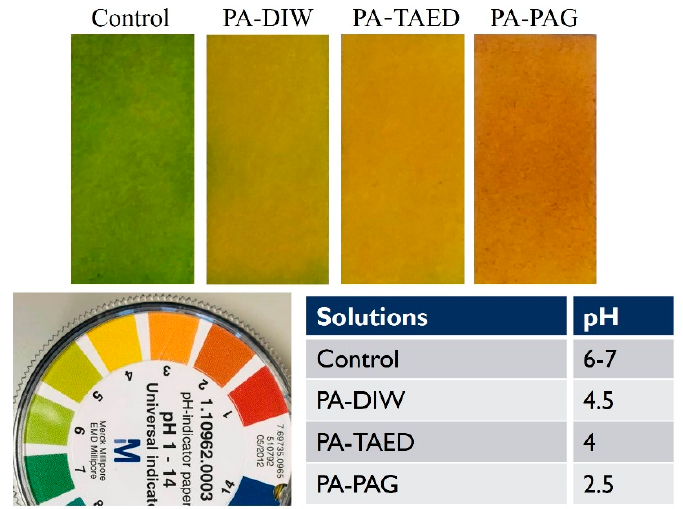
Figure 8. pH of PA-DIW, PA-TAED and PA-PAG in comparison to untreated DIW (Control).